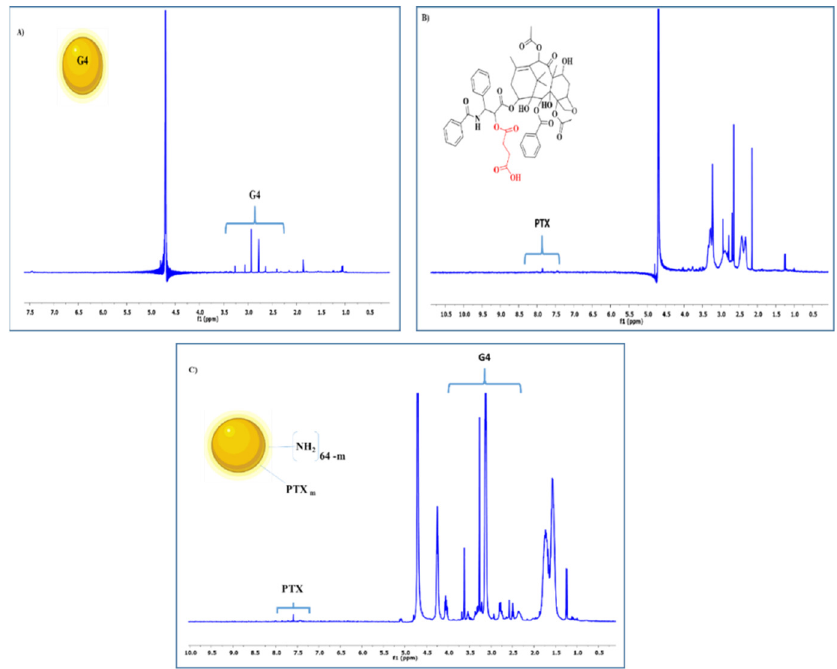
Figure 1. 1 H-NMR spectra of PAMAM G4 ( A ), PTX-SA ( B ), PAMAM G4-PTX ( C